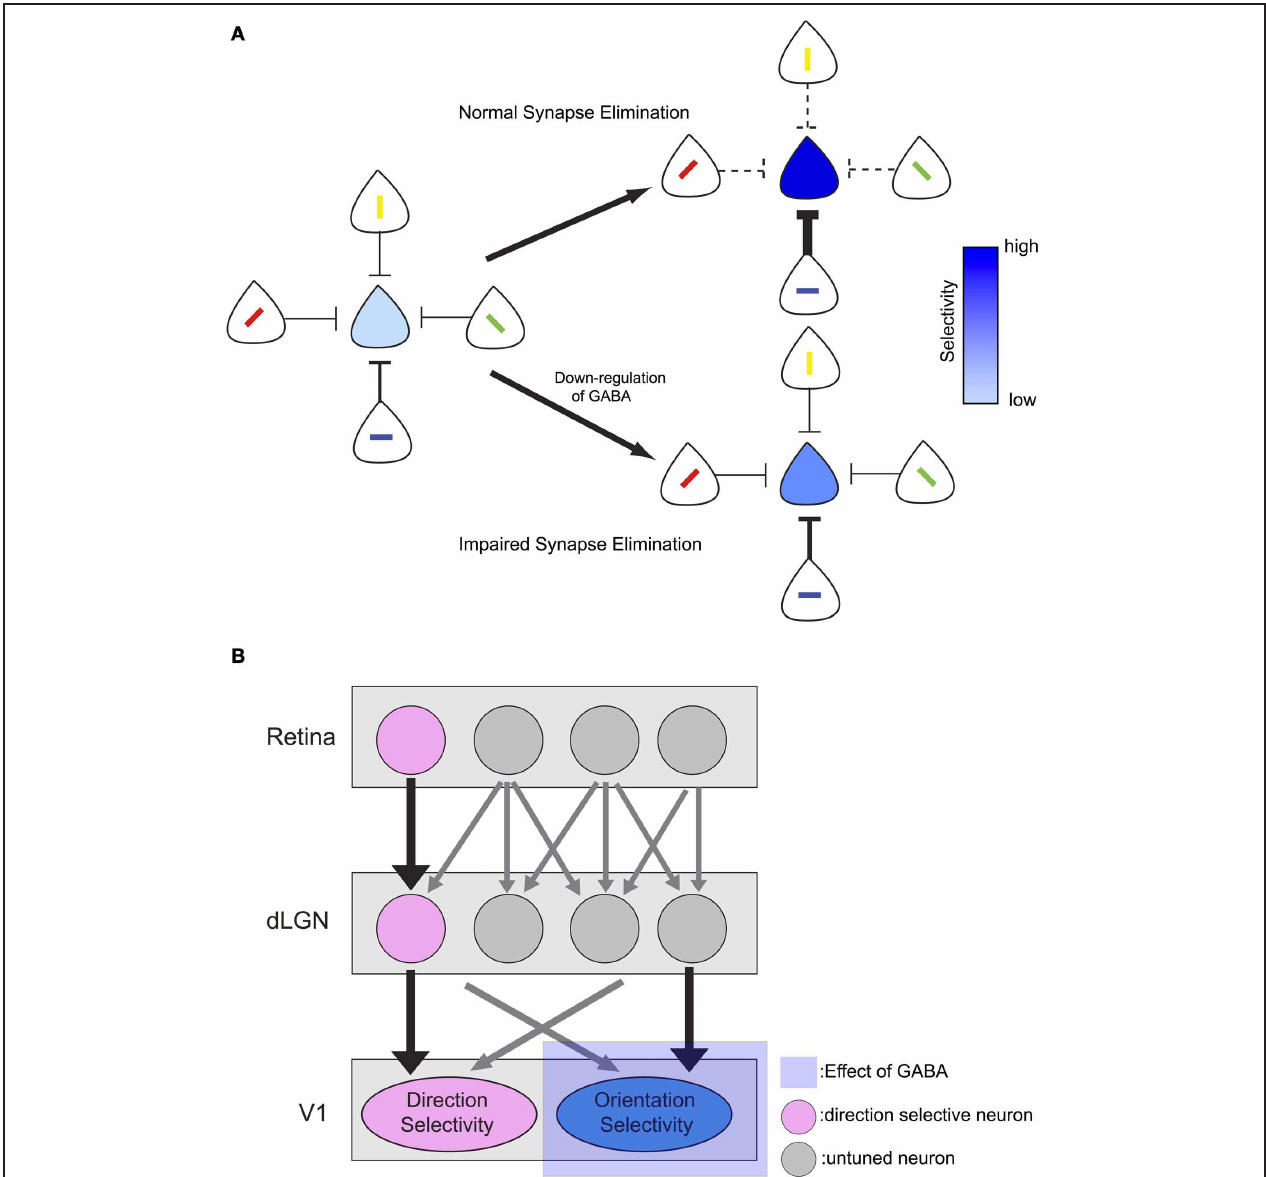
FIGURE 7 | Models of the effect of GABA down-regulation on visual selectivity. (A) Down-regulation of GABA leads to impaired synapse elimination and decrease orientation selectivity. Depth of blue color of each neuron on the center indicates strength of its selectivity. With normal amount of GABA, selectivity becomes sharp with LTP/LTD mechanism. In contrast,